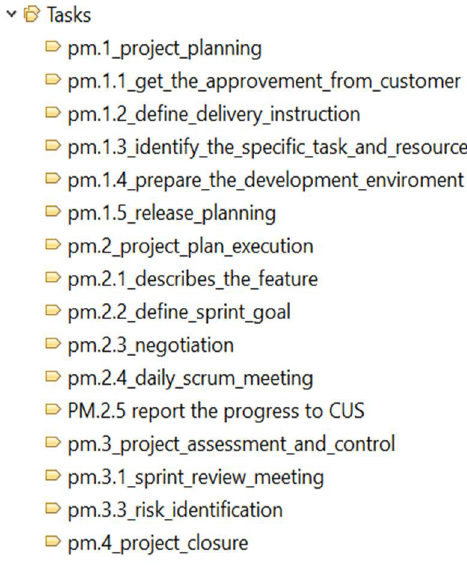
Figure 7. Defined roles in the modeling.